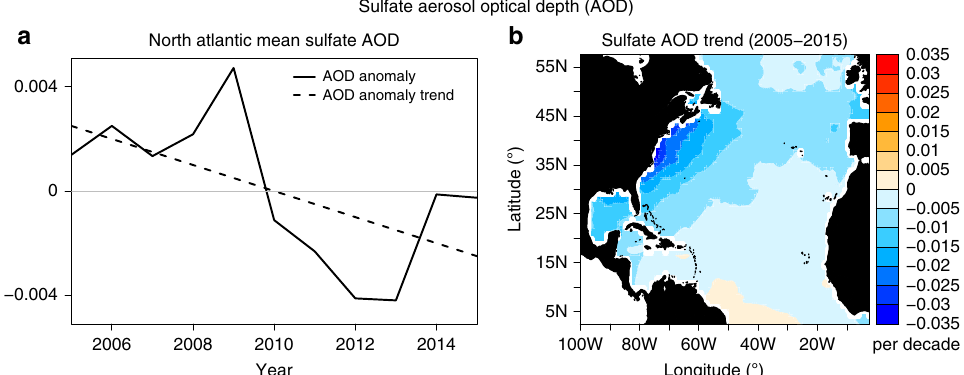
Fig. 6 Observed changes of anthropogenic sulfate aerosol optical depth. a The area-averaged sulfate aerosol optical depth (AOD) anomaly (solid black line) over the North Atlantic (80°W – 20°W, 0° – 60°N) and its linear trend (dashed black line) are shown for the period 2005 – 2015. b Sulfate AOD trends over the North Atlantic region. The sulfate AOD results are derived from the Modern Era Retrospective analysis for Research and Applications